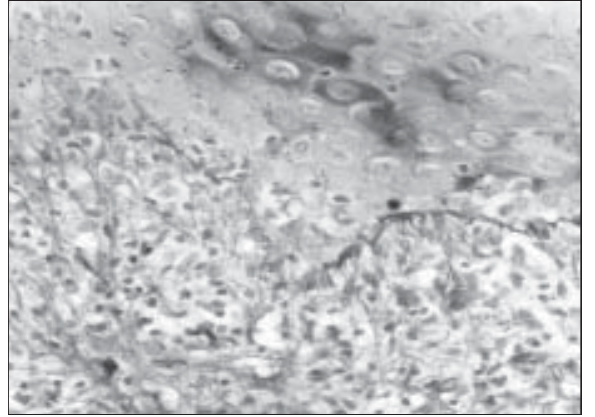
Figura 11 – Líquen plano cutâneo. Áreas de fragmentação e apagamento da membrana basal (PAS, aumento original 400x)